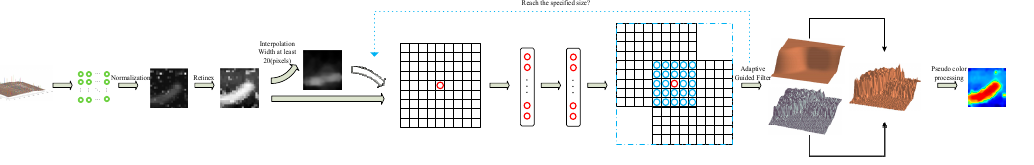
Figure 1. An illustration of the proposed methods.